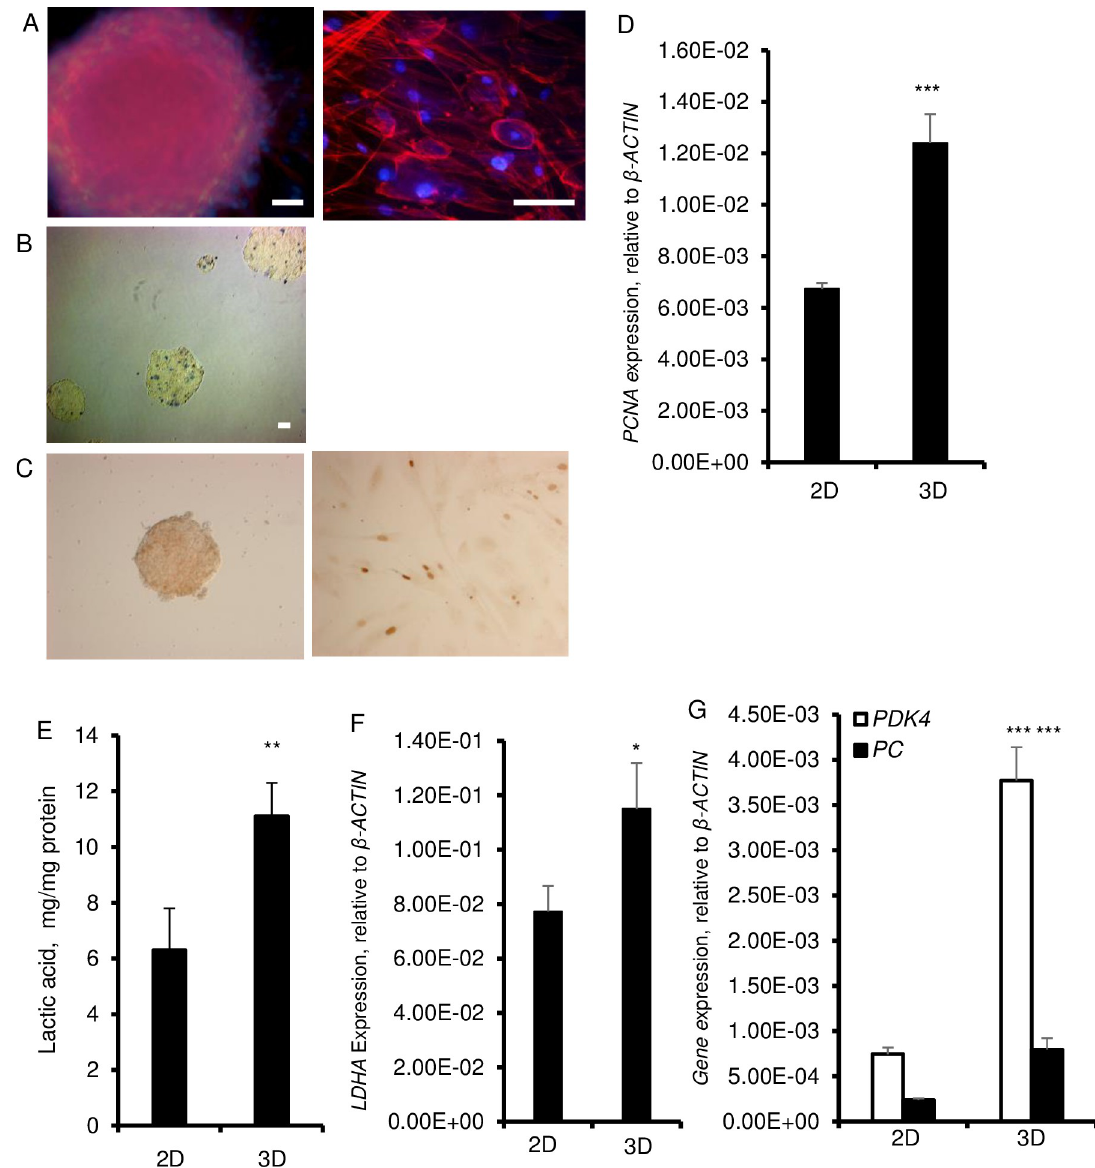
Fig 1. Cell morphology and metabolic features of fibroblasts grown in 3D. HDF were cultured in 2D and in 3D cultures on ultra-low attachment plates for 6 days in α MEM supplemented with 20% Knockout Serum Replacement, 5 ng/ml basic FGF, 10 ng/ml EGF and with 0.1 mM nonessential amino acids (NEAA). A. Staining of cytoskeletal F-actin with phalloidin (red fluorescence) in spheroids and monolayer cultures. Nuclei are stained with Hoechst (blue fluorescence). Spheroid was photographed at 20 × magnification (left) and monolayer cultured cells were photographed at 40 × magnification (right). Scale bars = 200 μ m. B. Staining of spheroids with trypan blue. C. BrdU staining (brown) in HDF spheroids (left) and in 2D culture after 6 days. D. Expression of proliferating cell nuclear antigen ( PCNA ) at the mRNA level. β -ACTIN was used as a housekeeping control. E. Amount of lactic acid in supernatant over a 6-day culture period. F. Expression of LDHA mRNA. β -ACTIN was used as a as a housekeeping control. G. Expression of PDK4 and PC mRNA. β - ACTIN was used as a housekeeping control. Data are shown as means ± SD from 3 independent experiments. Statistical significance is shown as � (p � 0.05), �� (p � 0.005), and ��� (p � 0.0005) in 3D as compared to 2D cultured